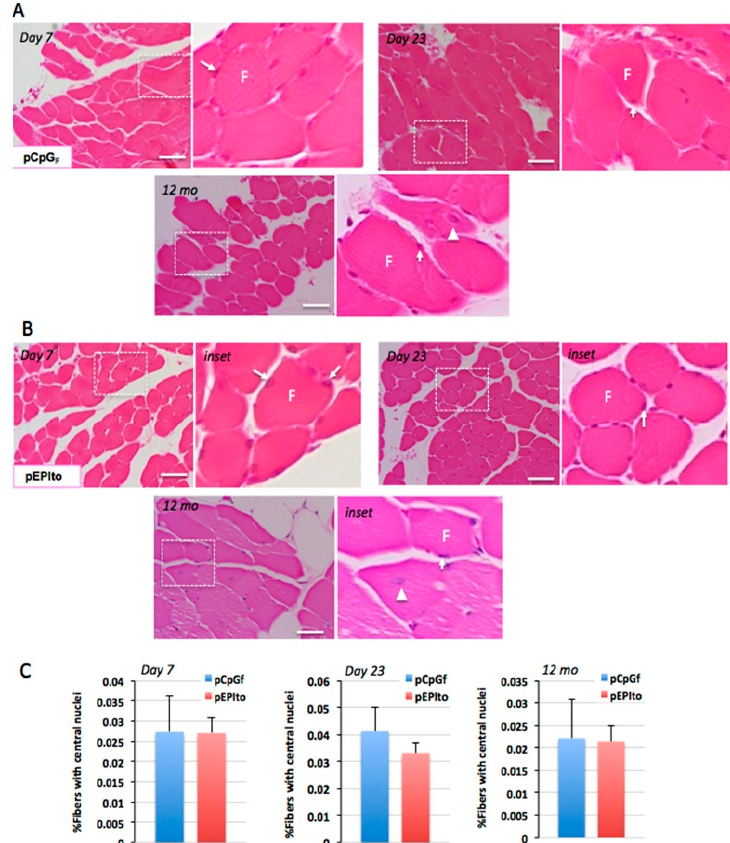
Figure 7. Analysis of muscle damage following gene delivery. Histological analyses at 7 days, 23 days, and 12 months, indicate neither plasmid, pCpGF ( A ) nor pEPIto ( B ), produced any significant signs of damage, as shown by H&E staining and visualization of skeletal muscle at 200 × magnification. Inset: selected areas at higher magnification to show nuclear positioning in muscle fibers. Scale bar represents 50 µ m. Arrows: normal positioning of nuclei at the periphery of muscle fibers, F; arrowheads: occasional atypical nuclei positioned centrally within fibers. ( C ) Analyses of percentage of muscle fibers displaying atypical central nuclei show no significant di ff erences ( p > 0.3) for either plasmid group for all three time points. (Reprinted from Figueiredo Neto et al. [59] with permission.)